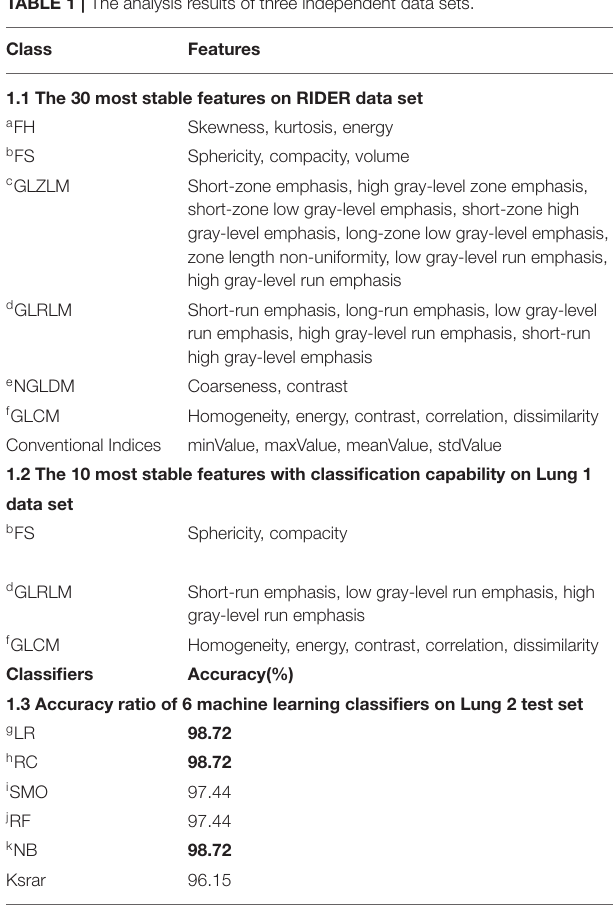
TABLE 1 | The analysis results of three independent data